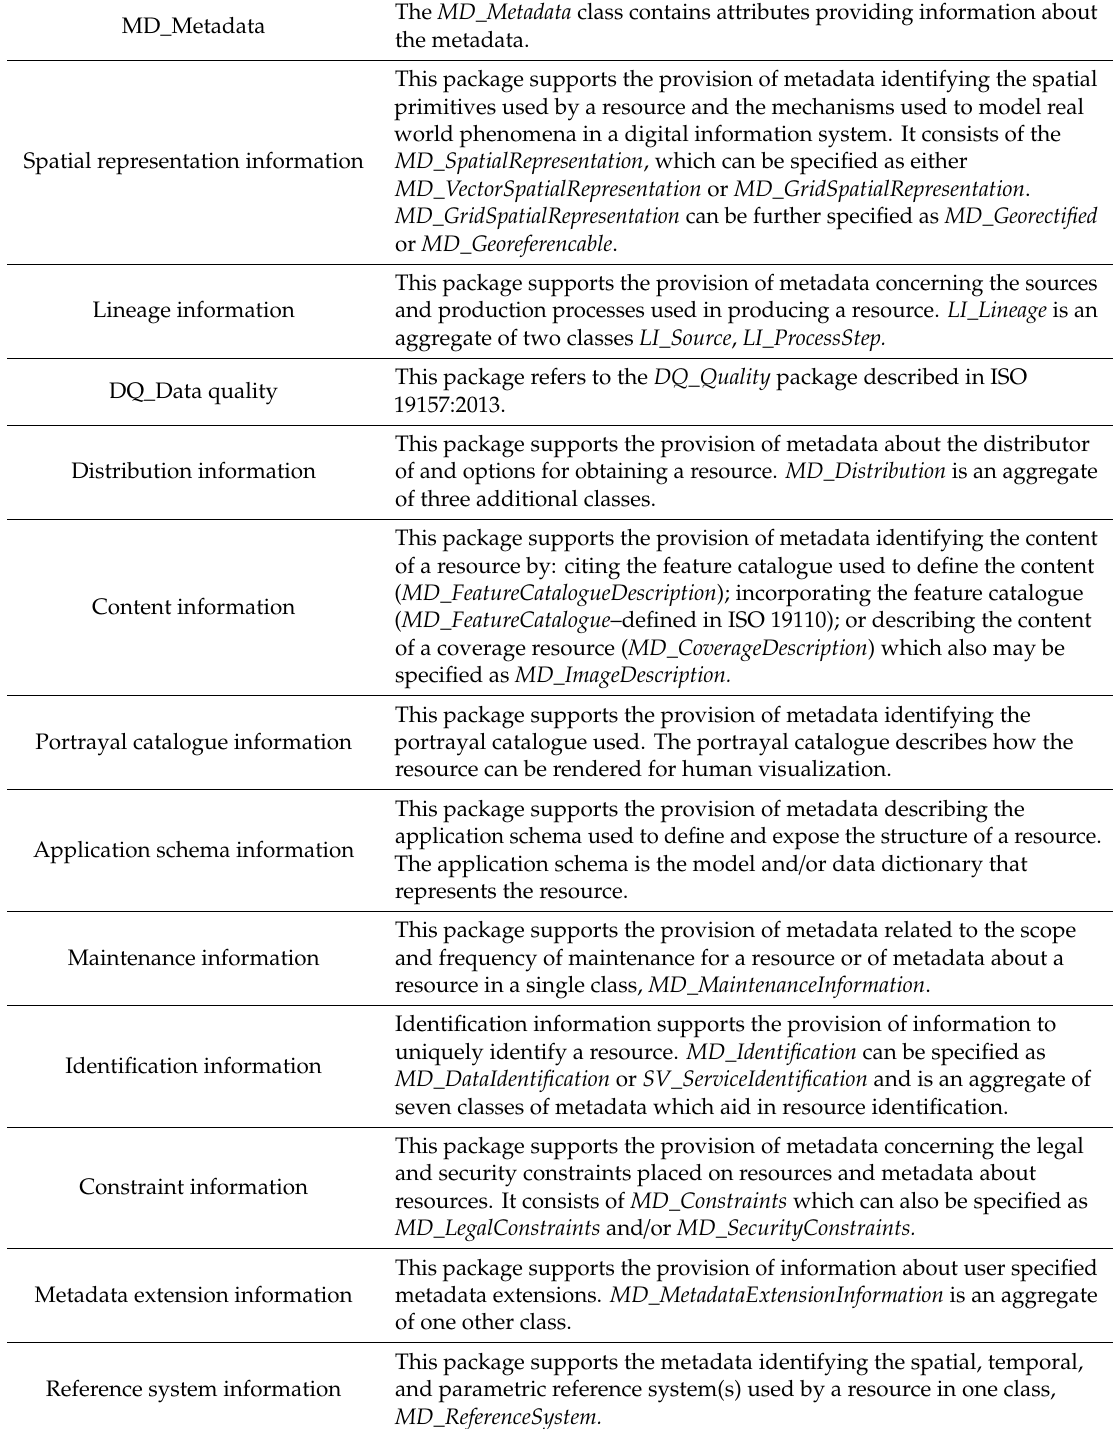
Table 3. Summary of the ISO 19115-1 high level metadata